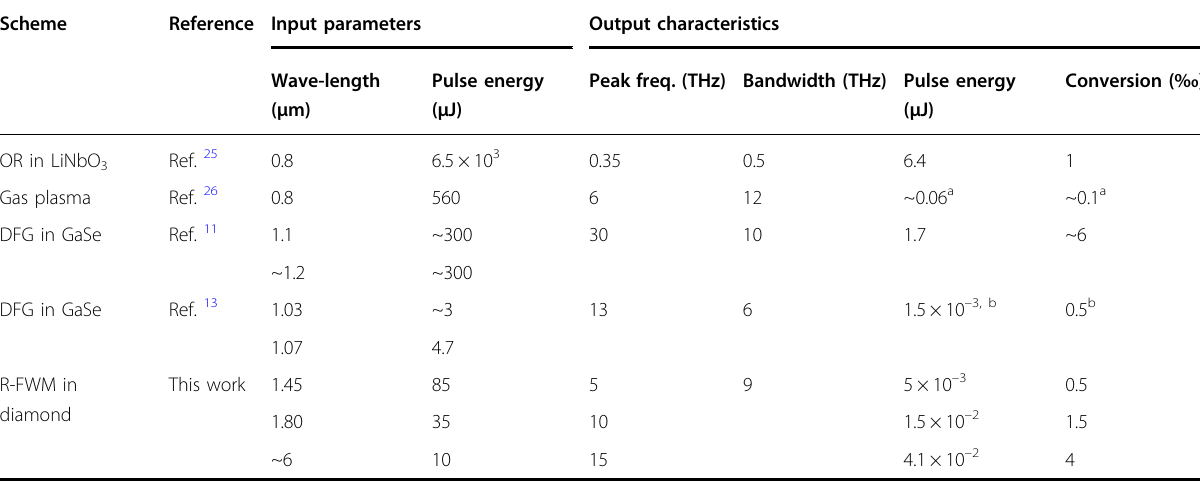
Table 1 Summary of THz generation schemes commonly used in small laboratories